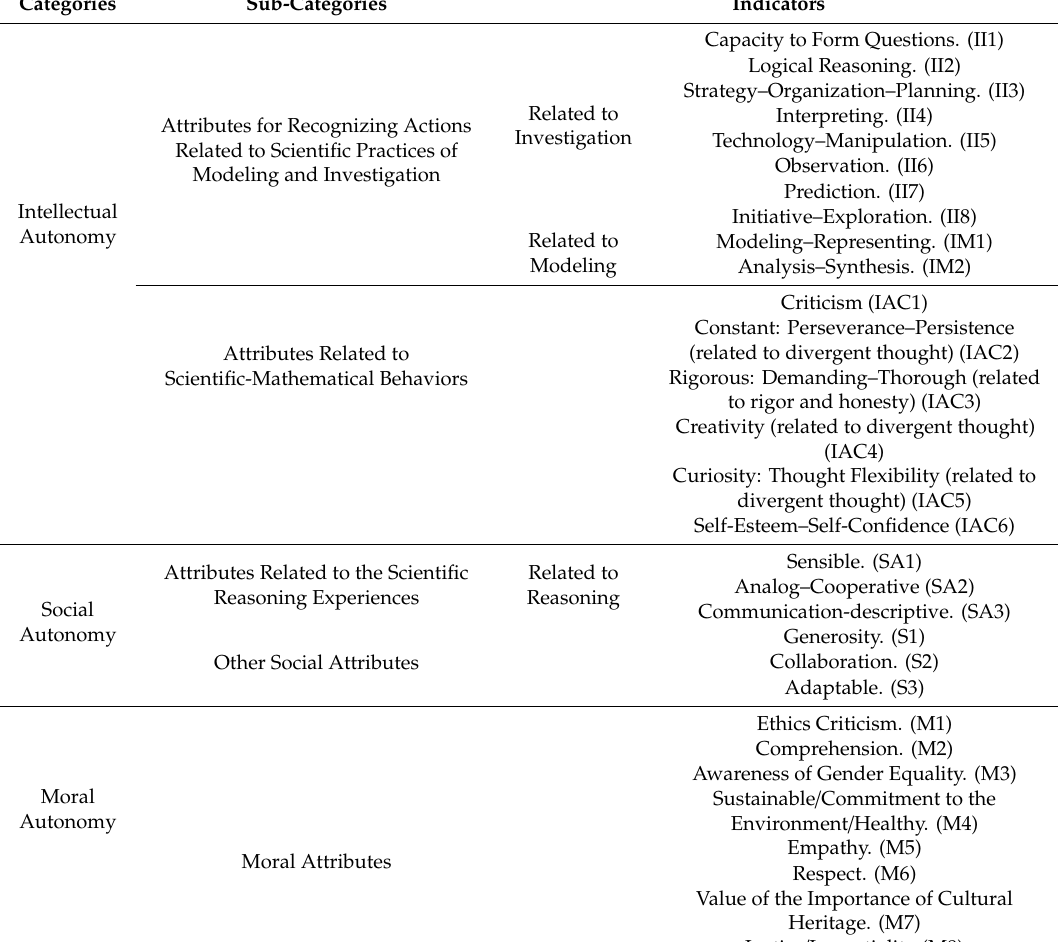
Table 1. Instrument selected for